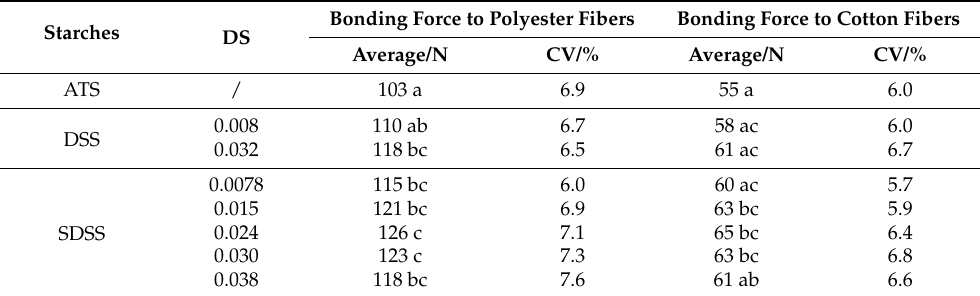
Table 3. Influence of sulfododecenylsuccination on the adhesion of starch to polyester and cot- ton